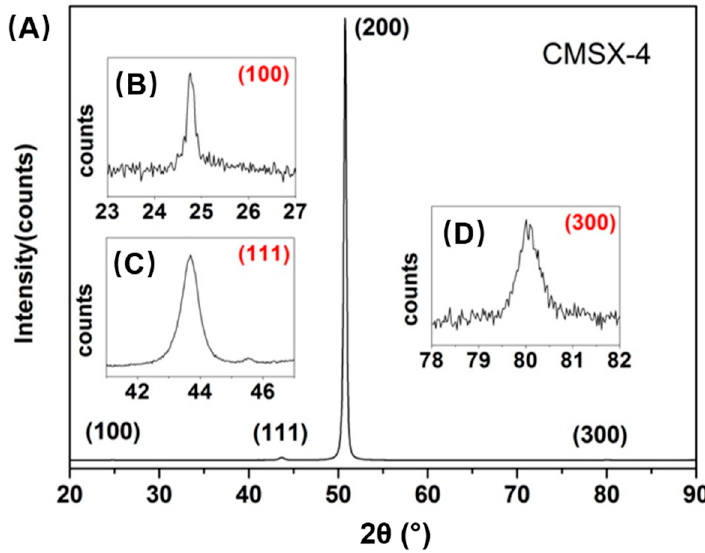
Figure 2. (A) XRD pattern of a CMSX-4 superalloy with a strong (200) texture, (B) (100) peak, (C) (111) peak, and (D) (300) peak.